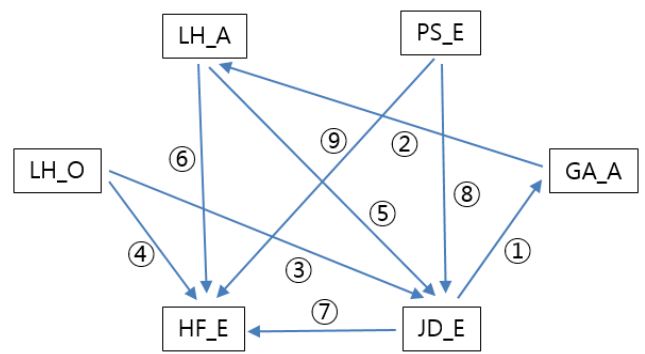
Figure 3. Transition of emotions and their mutual relationships among Love-Hate_Object (LH_O), Love-Hate_Agent (LH_A), Gratitude-Anger_Agent (GA_A), Pride-Shame_Event (PS_E), Joy-Dis- tress_Event (JD_E), and Hope-Fear_Event (HF_E): ① An agent causing JD events, ② LH toward an agent may rise from the GA, ③ target of LH of objects is identified, ④ target of LH of objects is expected, ⑤ target of LH of agents is identified, ⑥ target of LH of agents is expected, and ⑦ HF is generated when JD is expected, ⑧ JD is produced when PS occurs, and ⑨ HF is produced when PS is expected to